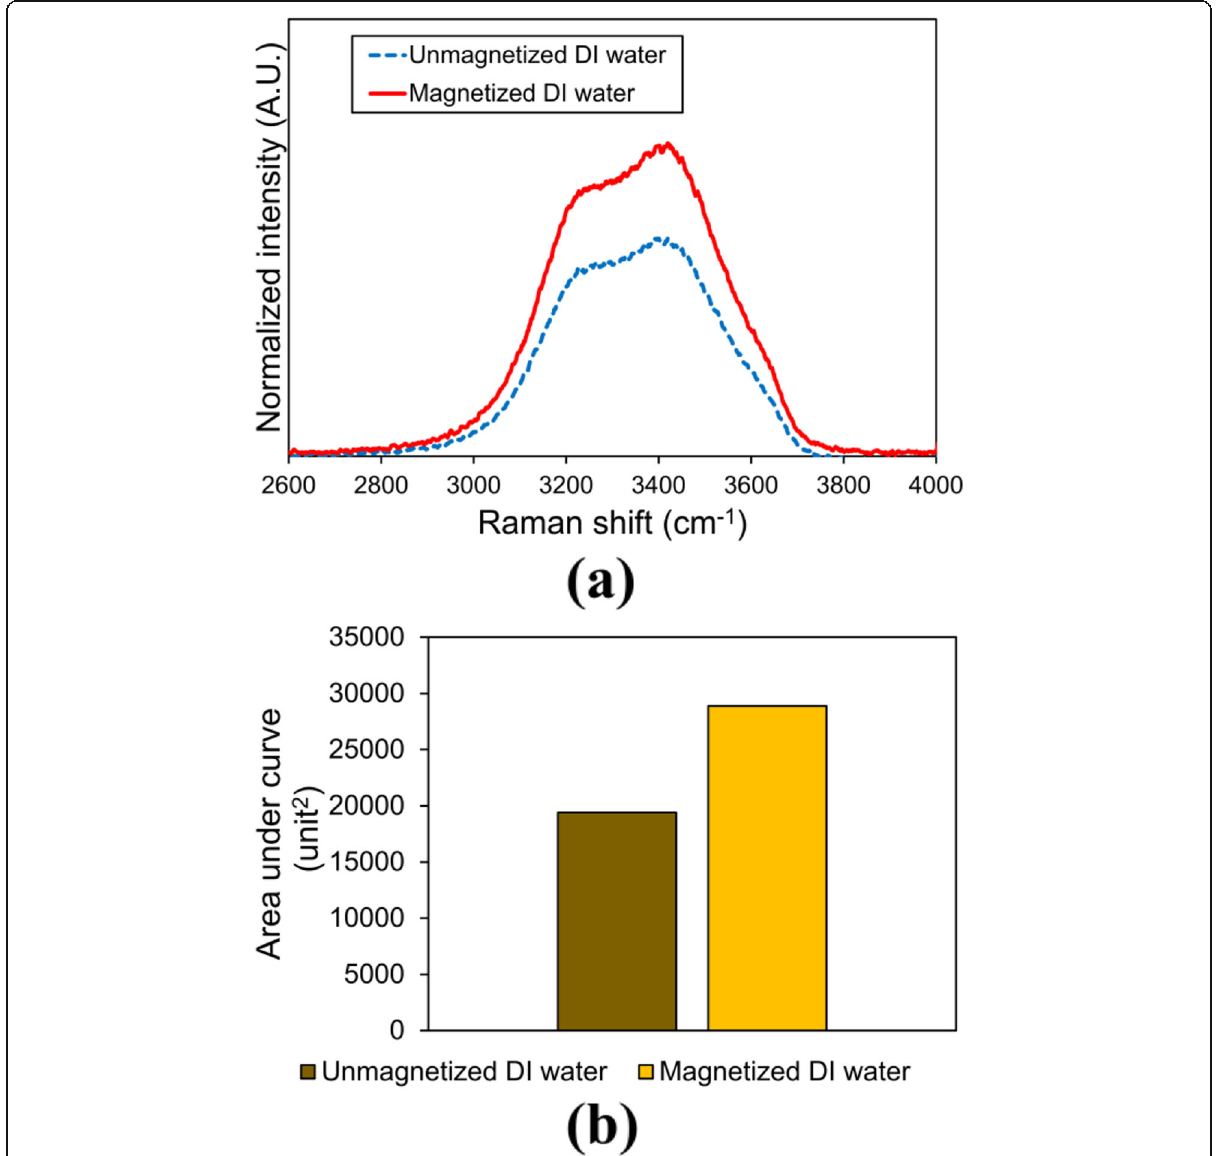
Fig. 5 a Raman spectra (from 2600 to 4000 cm − 1 ) for unmagnetized DI water, and magnetized DI water produced by water flowing at flow rate of 0.1 – 0.5 mL s − 1 ; and b Computed areas under curve for the unmagnetized DI water and magnetized DI water spectra,